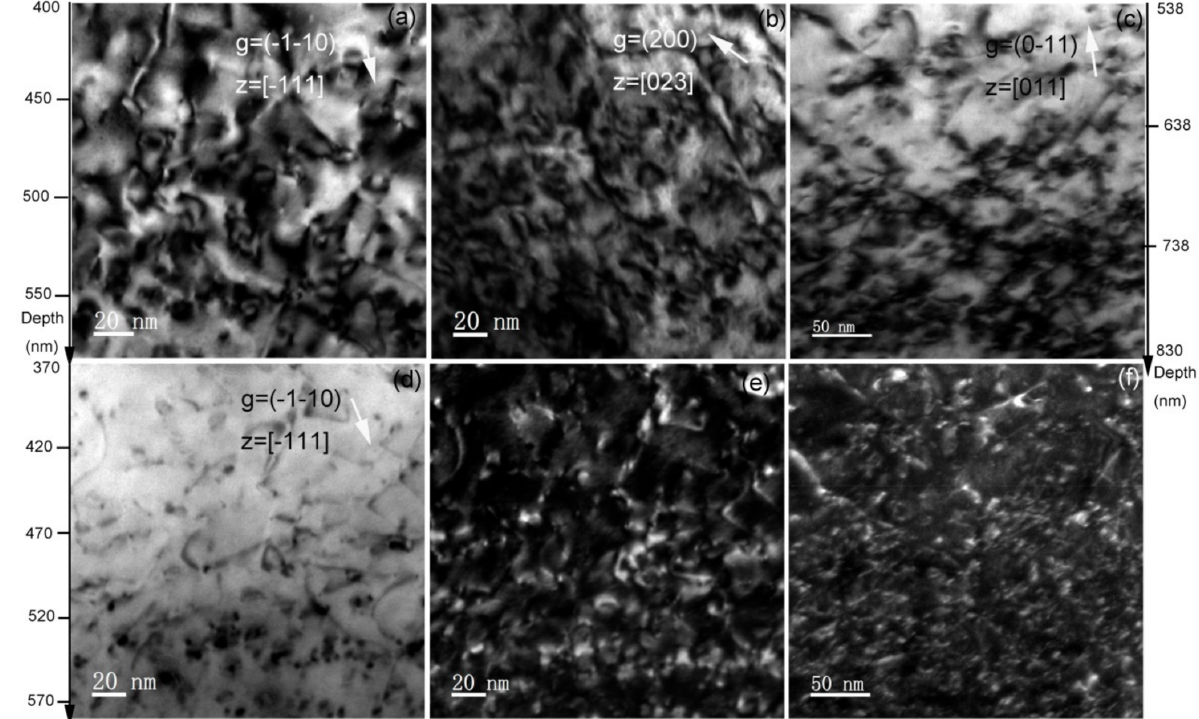
Figure 4. TEM micrographs of irradiation-induced dislocation loops in the He implantation with Fe pre-irradiation into SIMP steel to fluences of 1 × 10 16 Fe 10+ · cm − 2 and 5 × 10 14 He + · cm − 2 , under bright-field ( a – d ), and weak-beam dark-field ( e ). In comparison, the microstructures observed by bright-field and weak-beam dark field in the Fe-irradiated sample to a fluence of 1 × 10 16 Fe 10+ · cm − 2 were presented in ( c – f ),